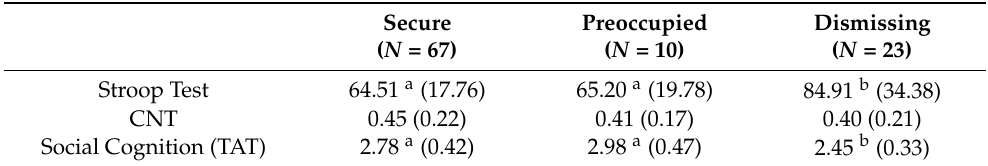
Table 3. Descriptive Statistics and Significant Attachment Classification Group Effects on the Execu- tive function and Social cognition dimensions.